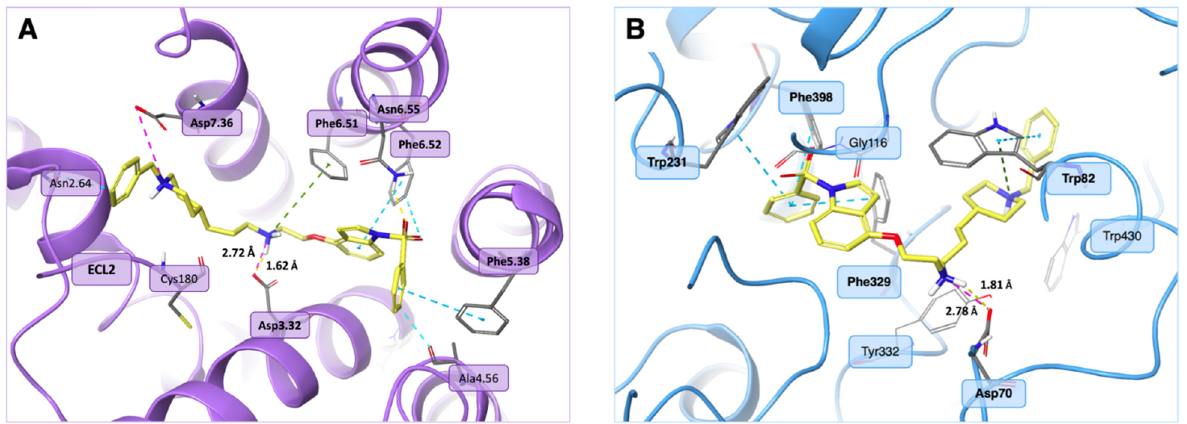
Figure 2. The predicted binding mode of compound 14 (yellow) in the site of the 5-HT 6 receptor ( A ; a single conformation of the optimised homology model built on the 5-HT 1B template PDB 4iar, represented in violet; ECL2 residues were hidden for clarity) and h BuChE ( B ; a conformational model extracted from the MD simulation trajectory of PDB 7awh, with the criteria of frame selection being the presence of the most prevalent interactions indicated in the ligand–protein contacts analysis, represented in blue). Amino acid residues engaged in the ligand binding, thus forming H-bonds (dashed yellow lines), salt bridges (dashed pink lines), π - π /CH- π stacking interactions (dashed cyan lines) and cation- π interactions (dashed green lines) are presented as thick sticks. Distances between atoms forming H-bonds ( A 1.62 Å; B 1.81 Å) and salt bridges ( A 2.72 Å; B 2.78 Å) are presented beside (in B measured as average of the trajectory values with the formation cut-off 2.5 Å and 3.2 Å,